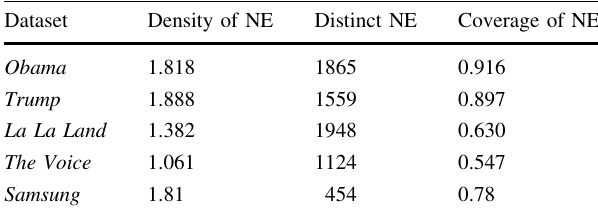
Table 2 Dataset characteristics related to